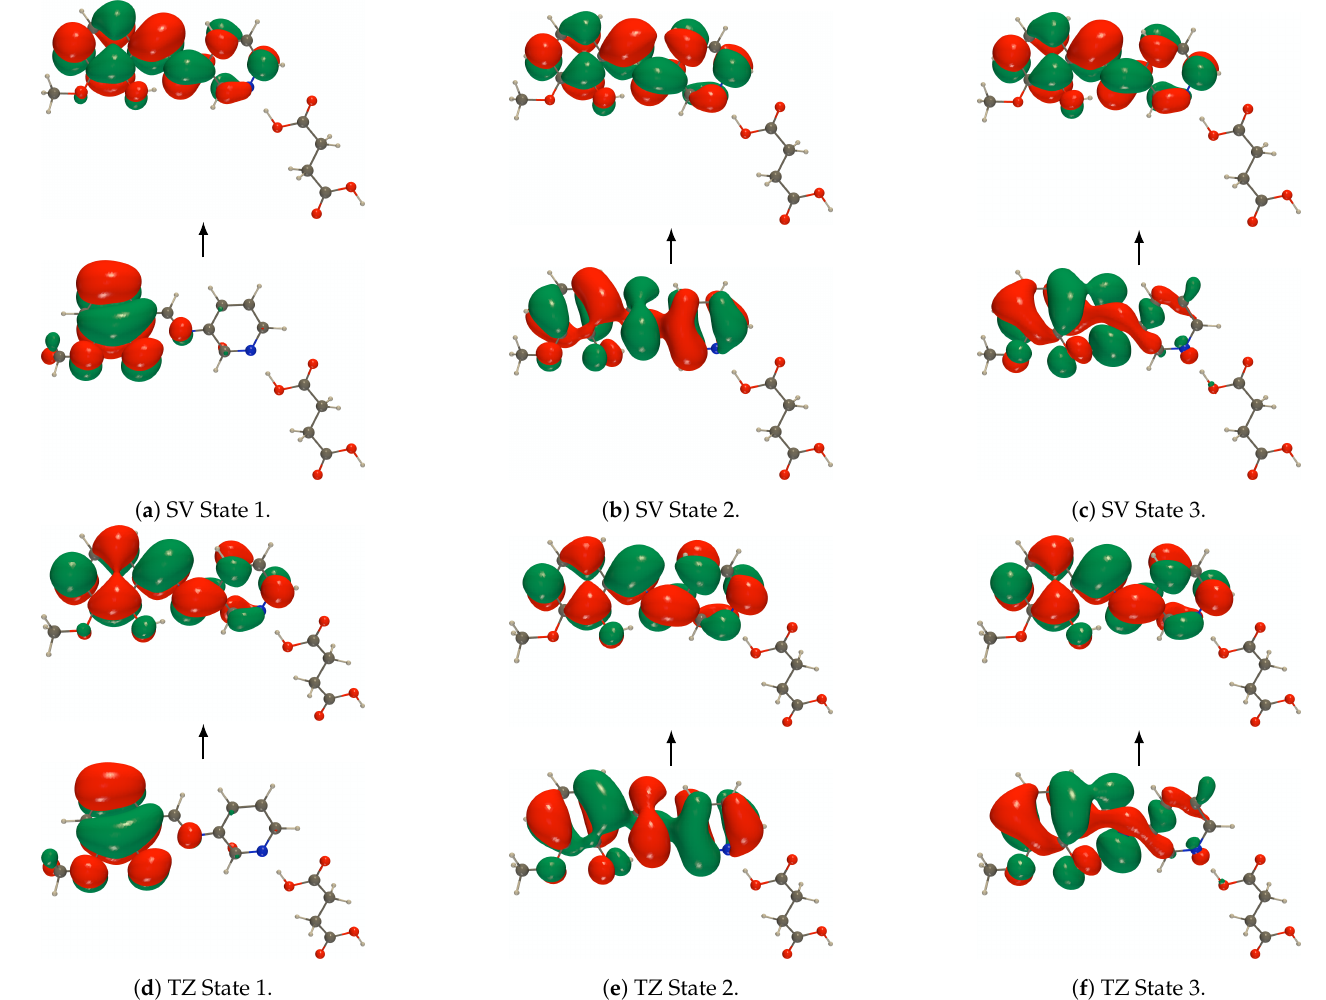
Figure A7. RI-CC2 def2-SVPD (SV) and def2-TZVPD (TZ) NTOs (holes below the arrows and particles above them, the red (green) lobes are the positive (negative) ones) of the embedded PYV3 + SA [PYV3 · SA] enol form (isovalue of